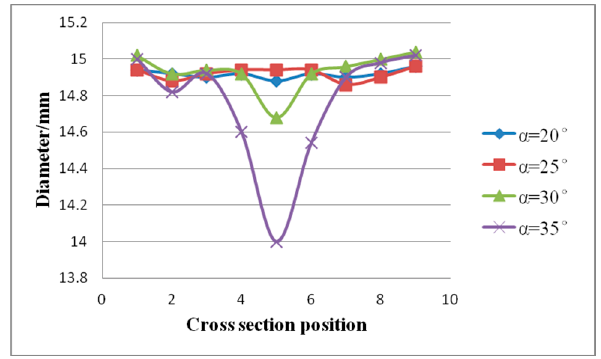
Figure 6. Diameters at the measured positions ( β = 7 ◦ ).